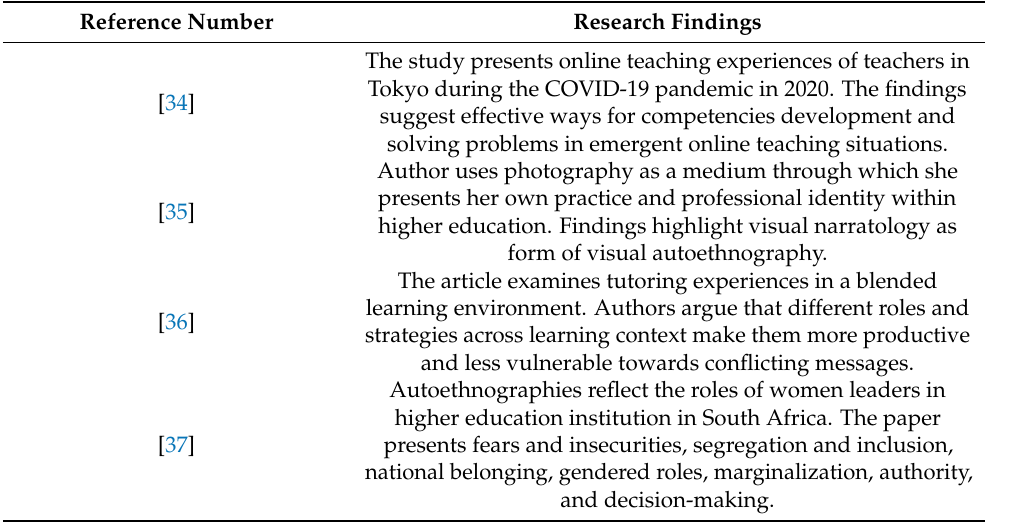
Table 2. Autoethnography research publications on education